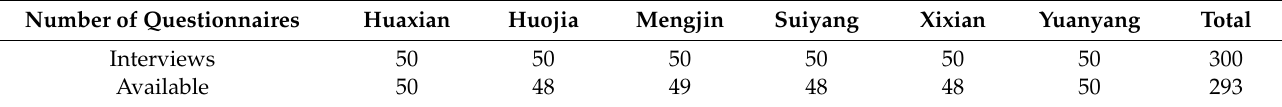
Table 1. Distribution of questionnaire samples.